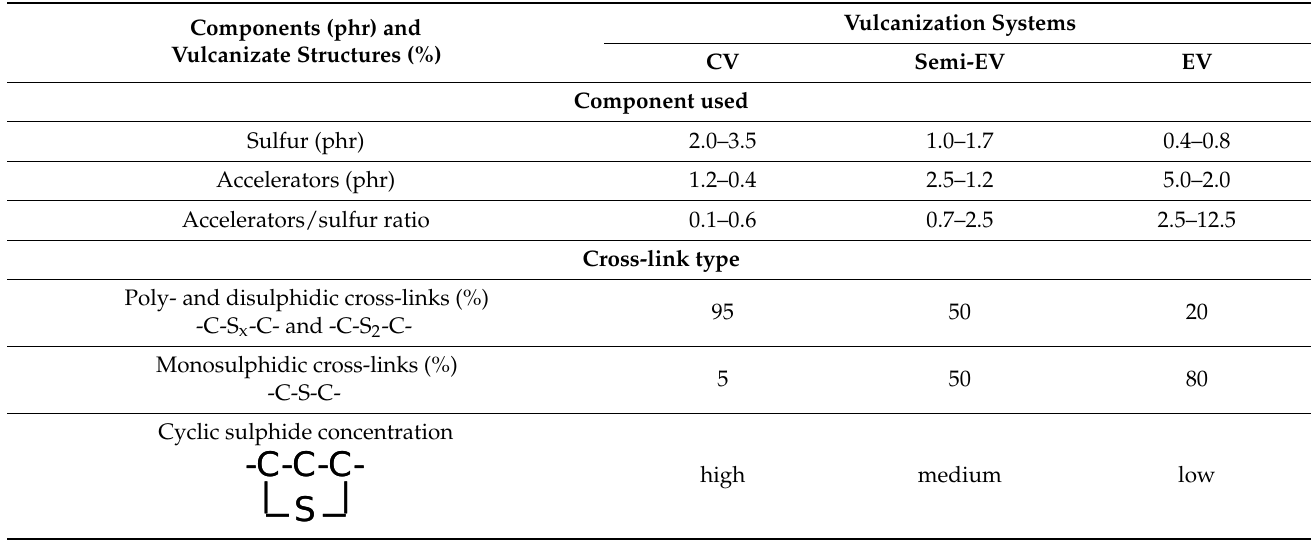
Table 6. Components used in conventional (CV), semi-efficient (semi-EV), and efficient (EV) vulcan- ization systems and vulcanizates’ structures (cross-link type).